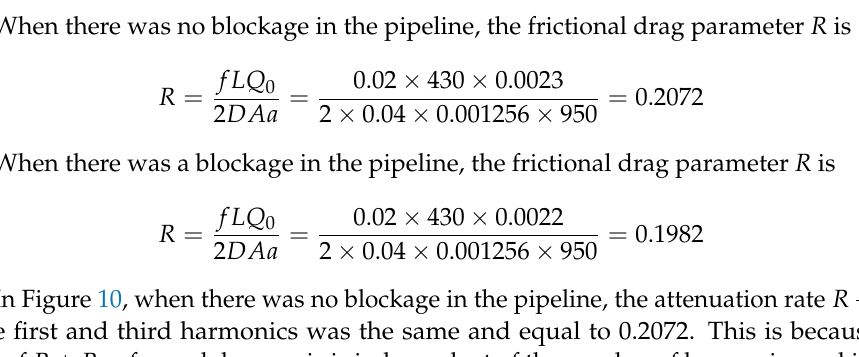
Figure 10. Exponential attenuation curves of harmonics.